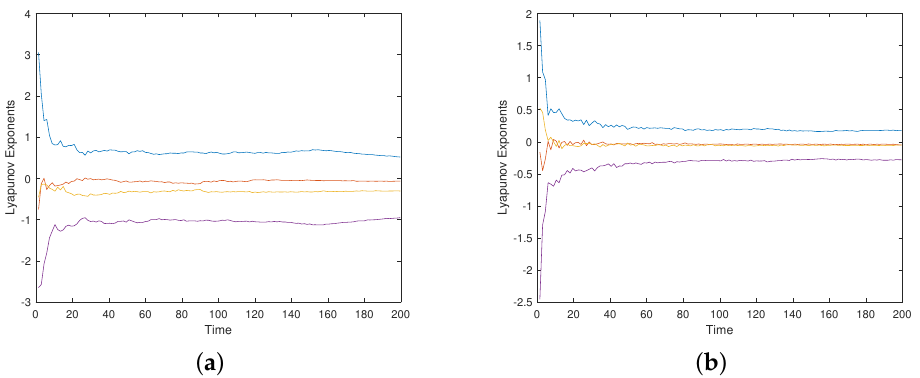
Figure 5. The Lyapunov exponent spectrum system (12): ( a ) when µ = 0.4 and f = 13.3; ( b ) when µ = 0.1 and f =